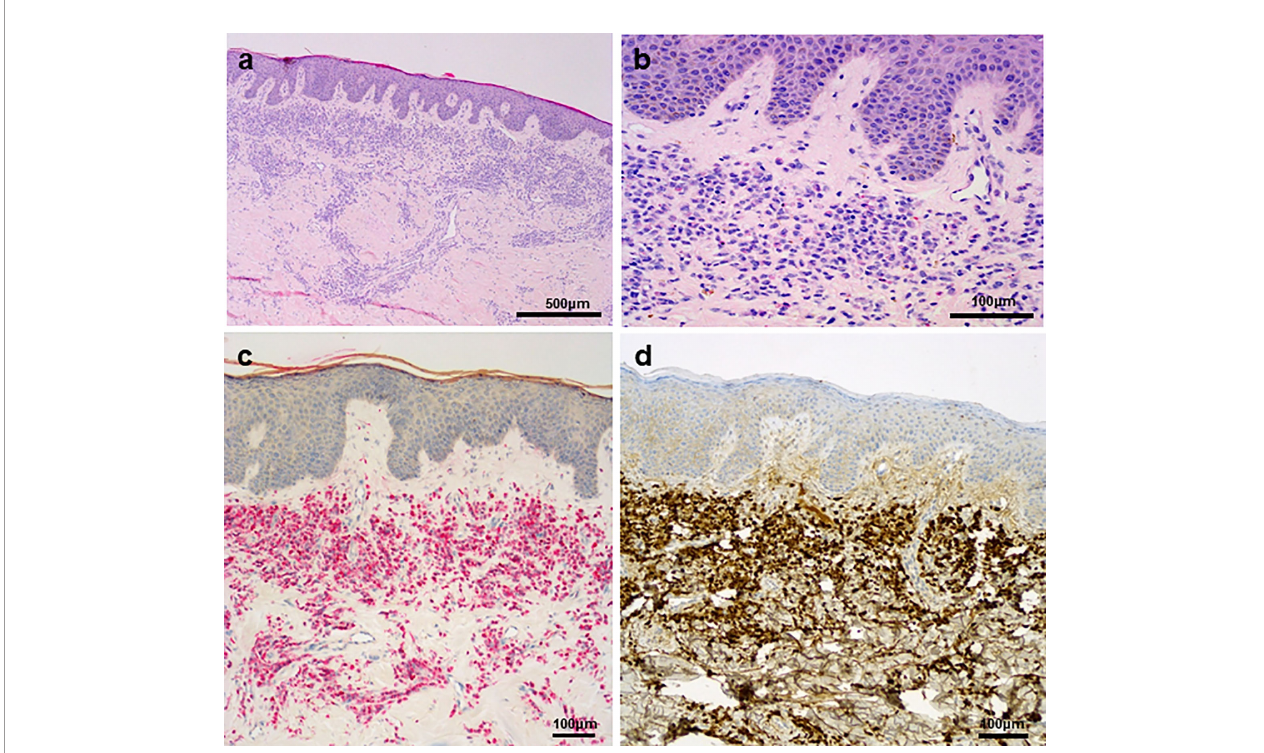
FIGURE 2 | (A) Skin biopsy with lichenoid leukaemic in fi ltration in the upper dermis. (B) Grooved nuclei and granulated eosinophilic cytoplasm are visible in the blasts. (C, D) There is a strong chloroacetate esterase reaction (C) in the in fi ltrate, as well as MPO reaction (D)